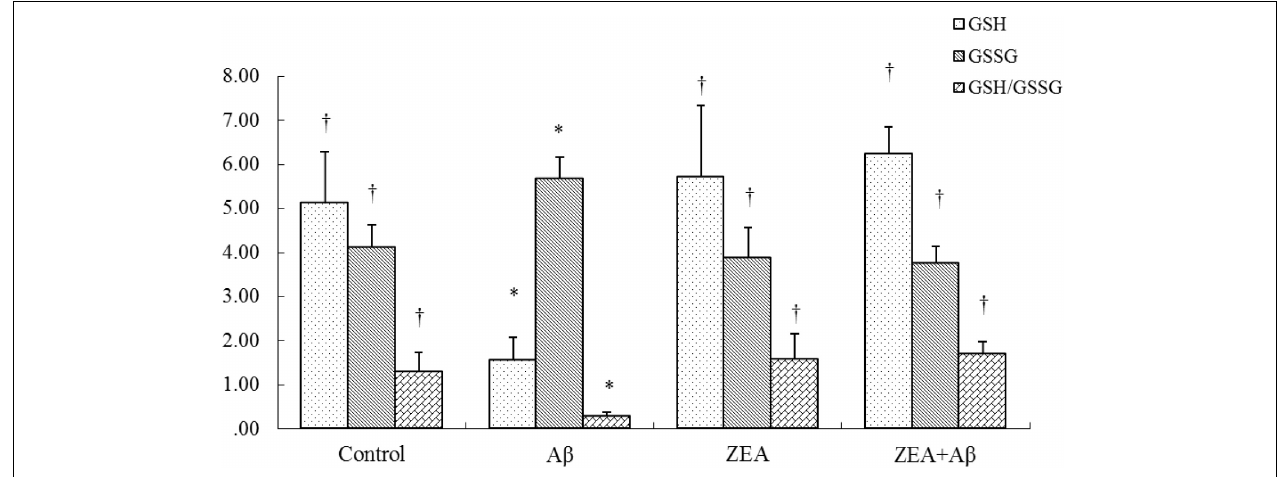
FIGURE 4 | Neuroprotective effects of ZEA on GSH, GSSG, and GSH/GSSG in plasma of learning and memory impairment rats induced by A β 1–42. The kit assay was used in rat plasma from four treatment groups mentioned before ( n = 12 per group). All the data were shown as mean ± SD, and analyzed by the one-way ANOVA test [ Post Hoc (LSD) test]. ∗ Significantly different from the Control group ( p < 0.05). † Significantly different from the A β group ( p <